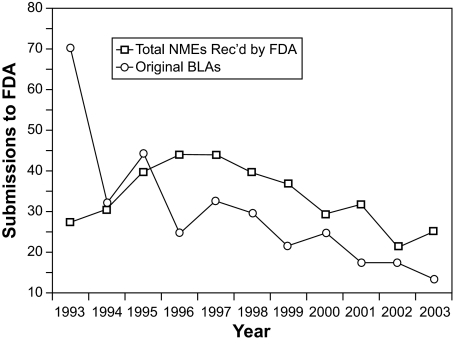
Number of submissions of new molecular entities (NMEs) and biologics license application (BLA) to FDA over the past 10 years. (U.S. Department of Health and Human Services-Food and Drug Administration 2004)